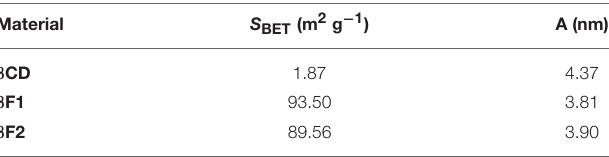
TABLE 4 | Parameters obtained from nitrogen adsorption–desorption analysis at 77 K.